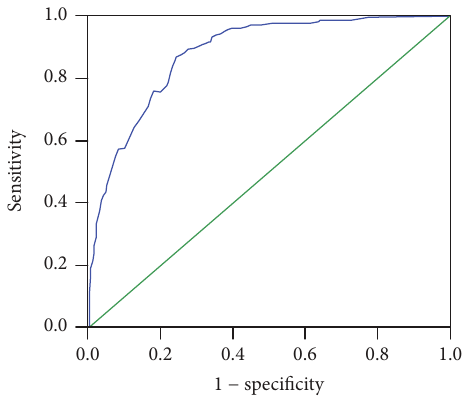
Figure 1: ROC curve of risk factor score.